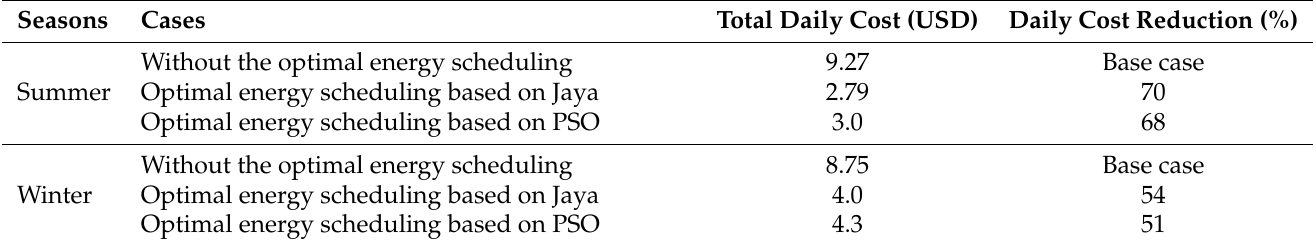
Table 6. Comparison between base case, Jaya, and PSO in summer and